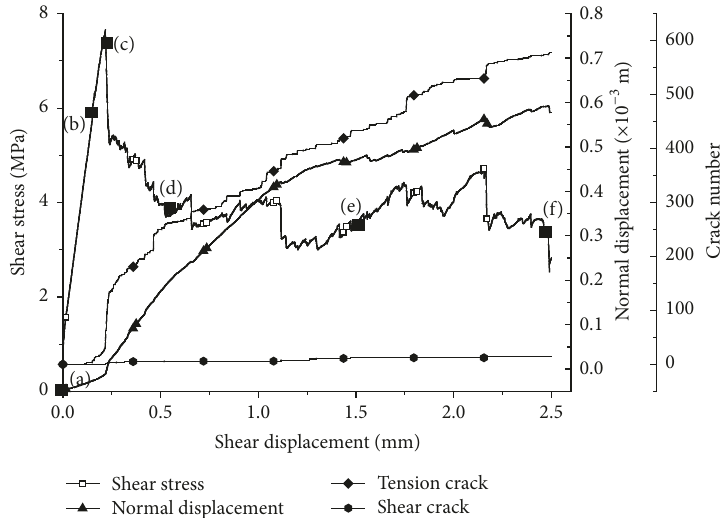
Figure 12: Evolution of the shear stress, number of cracks, and normal displacement.